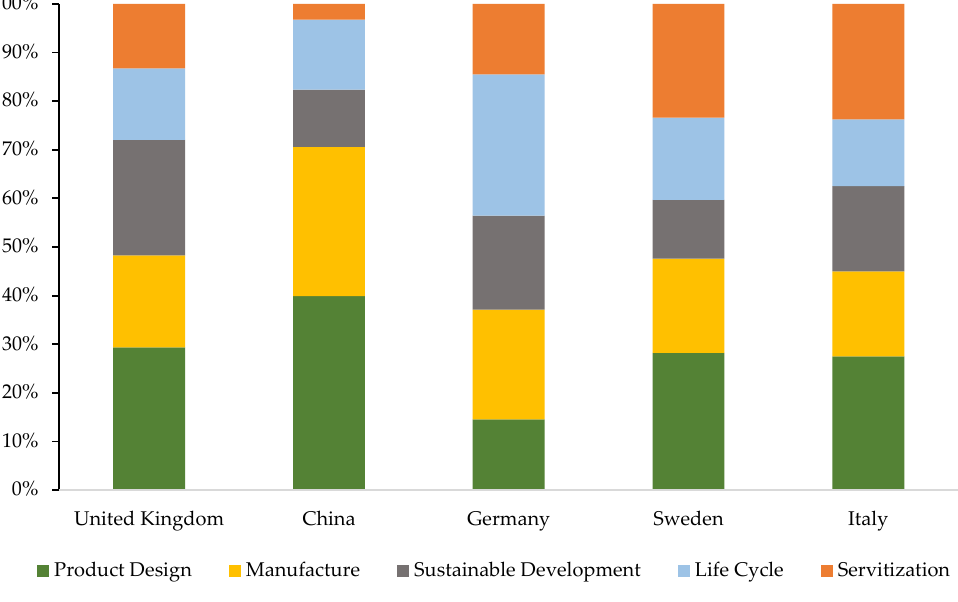
Figure 10. Main PSS keywords for the most prolific countries.